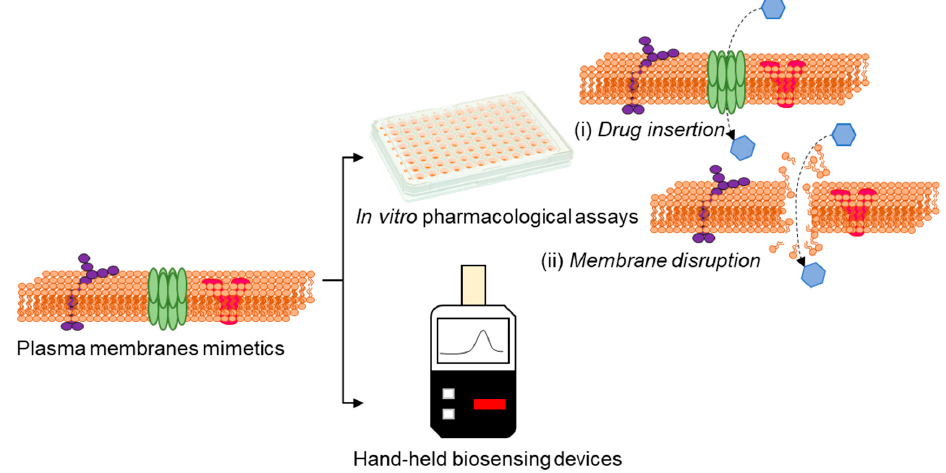
Figure 6. Advances in technologies using plasma membrane mimetics allows us to perform drug discovery and sensing by in vitro assays based on drug insertion ( i ) and membrane disruption ( ii ) and conceive the possibilities of real-time membrane-based hand-held biosensing devices.